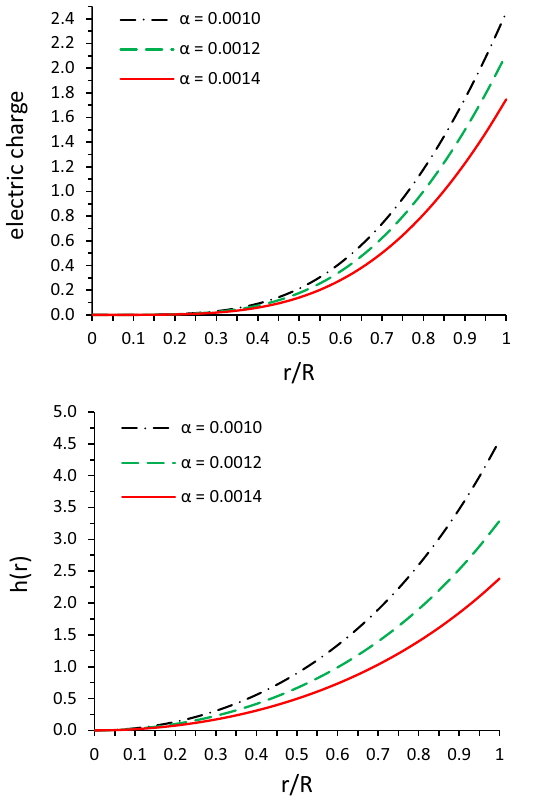
Fig. 1 The behavior of electric charge, q ( r ) (top left), deformation functions, | f ( r ) | (top right) and h ( r ) (bottom left), and bottom right figure for gravitational potentials e λ (solid lines) and e ν (dashed lines) have beenplottedagainst theradial coordinate r / R ofdifferent compact objects as PSR J1614-2230 (black curve for α = 0 . 001), 4U1608-52